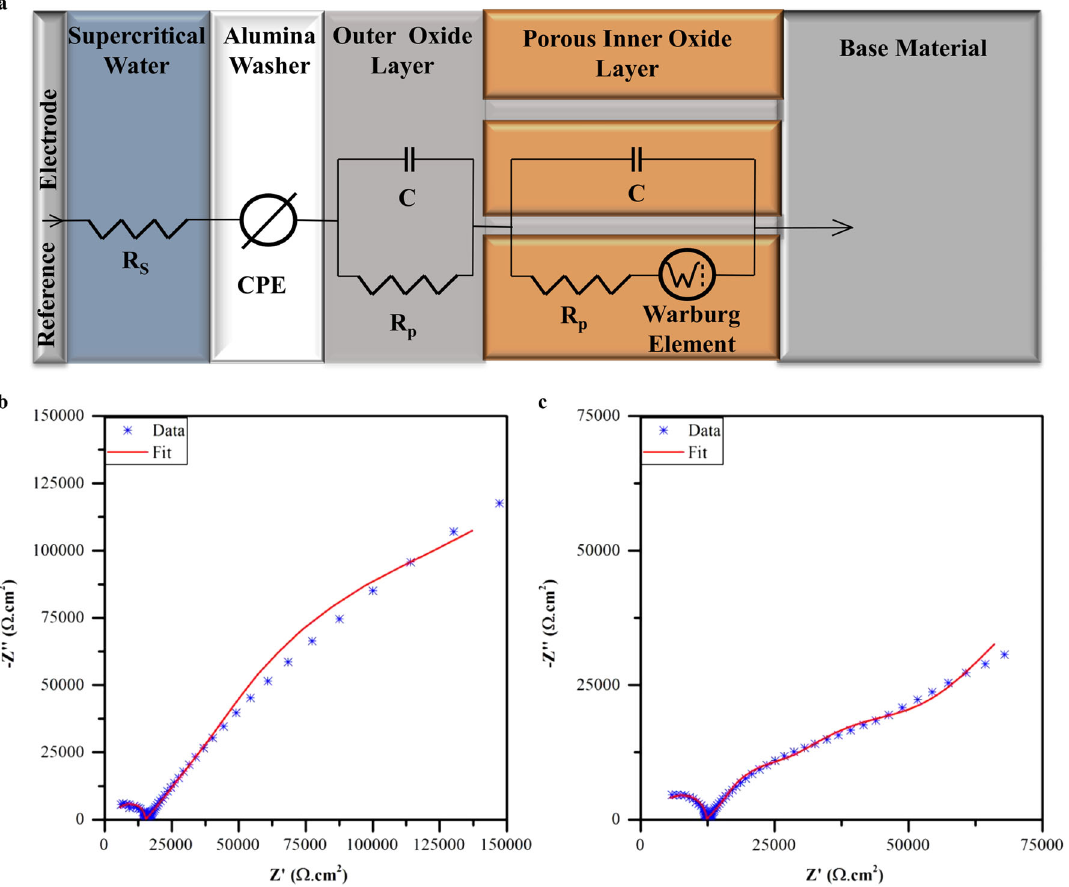
Fig. 2 Electrochemical impedance spectroscopy: a Equivalent circuit used to model the corrosion behavior for electrochemical impedance spectroscopy data, b Nyquist plot for SS316 exposed to supercritical water at 530 °C, c Nyquist plot for SS316 exposed to ultra-supercritical water at 600